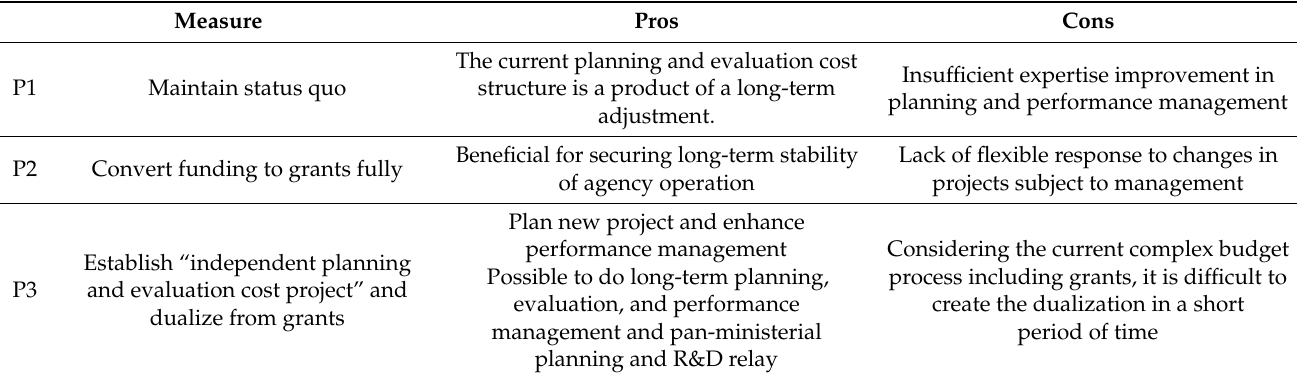
Table 8. Pros and cons of each alternative to reorganizing the budget process for planning and evaluation costs. Measure Pros Cons The current planning and evaluation cost P1 Maintain status quo structure is a product of a long-term